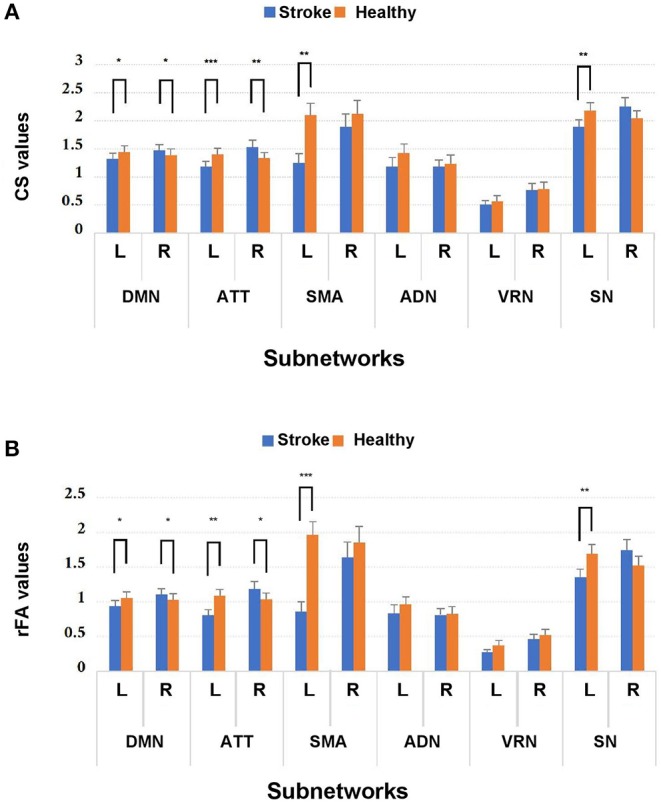
Comparison of (A) CS and (B) rFA values between stroke patients and healthy controls among the 12 subnetworks. *p < 0.05, **p < 0.01, and ***p < 0.001. Blue and orange bars represent stroke and healthy controls, respectively. DMN, default mode network; ATT, attention network; VRN, visual recognition network; ADN, auditory network; SMA, sensory-motor areas; SN, subcortical network; L, left; R, right.